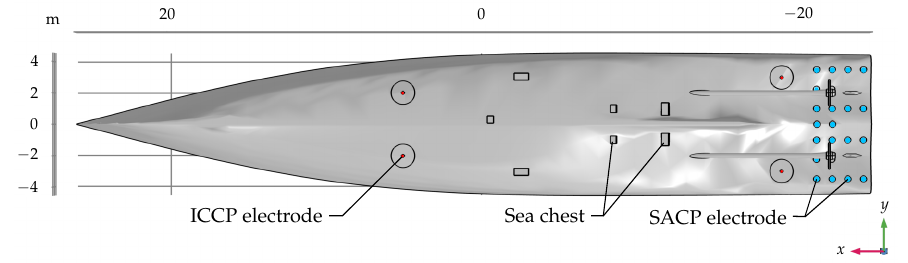
Figure 1. Bottom view of the generic ship model installed with a four-zone impressed current cathodic protection (ICCP) system (red circular patches) and an additional sacrificial anode cathodic protection (SACP) system (blue circular patches) at the stern region and inside the sea chests (not visible here) to smooth the electric potential distribution of the hull for corrosion protection. Furthermore, the propellers are approximated as